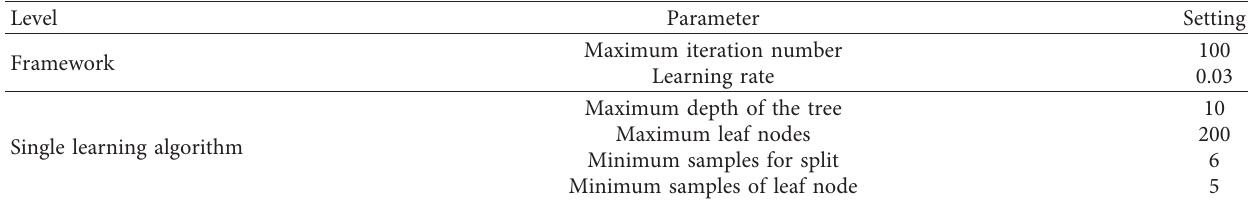
Figure 1: Flowchart of implementation of GBRT. Table 1: Model parameters of GBRT.